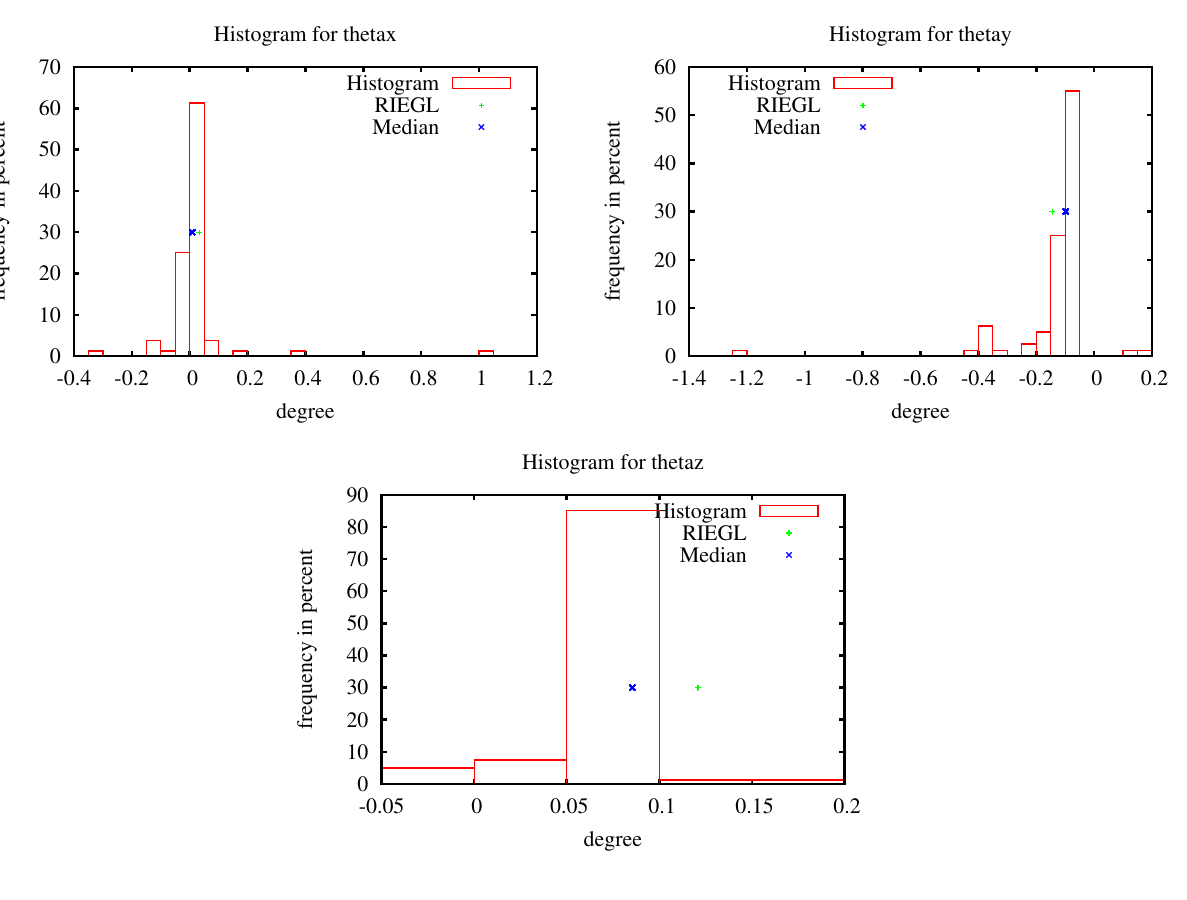
Figure 8. Histograms of the results of the boresight calibration. The bucket size is 0 . 05 ◦ .